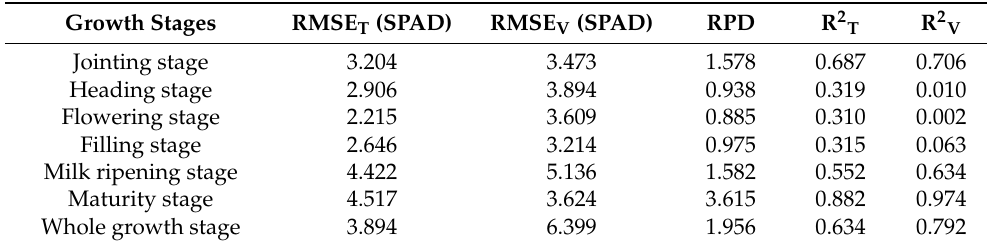
Table 5. Estimation results of chlorophyll concentration in various growth stages with spectral indices set as input